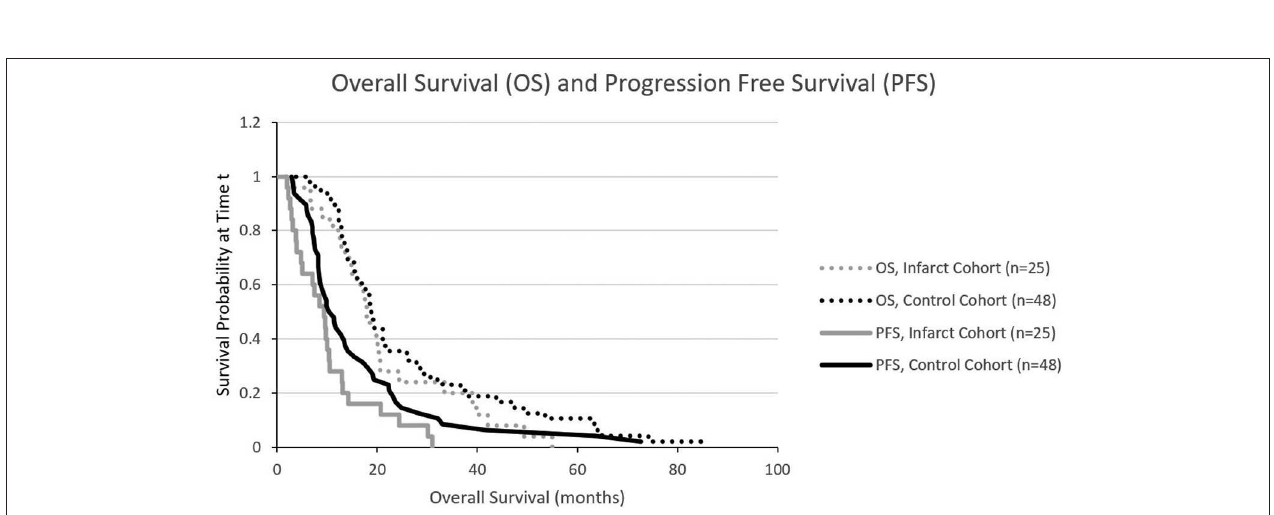
FIGURE 4 | Kaplan Meier curves illustrating progression free survival (PFS) and overall survival (OS). There is no significant difference in PFS or OS.